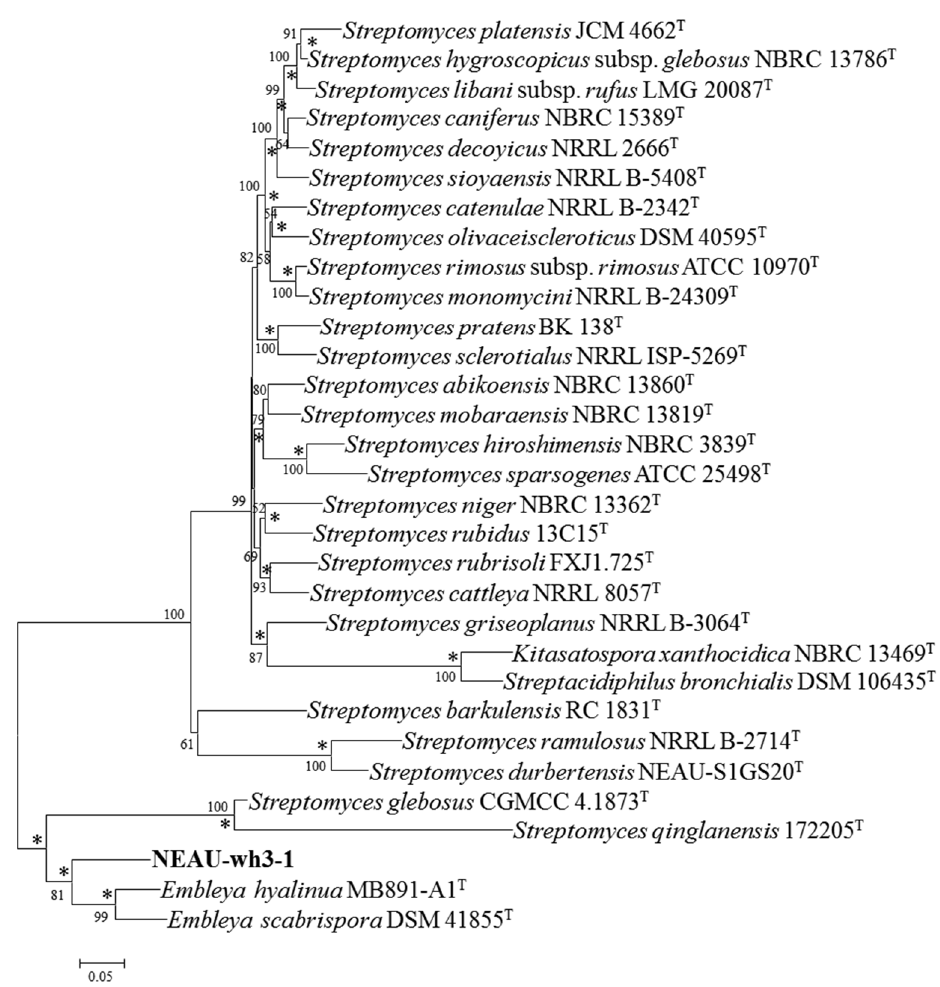
Figure 4. Neighbor-joining tree based on multilocus sequence analysis (MLSA) analysis of the concatenated partial sequences (1979 bp) from five housekeeping genes ( atp D, gyr B, rec A, rpo B, and trp B) of strain NEAU-wh3-1 (in bold) with related taxa. Only bootstrap values above 50% (percentages of 1000 replications) are indicated. Asterisks indicate branches also recovered in the maximum-likelihood tree; Bar, 0.05 substitutions per nucleotide position.